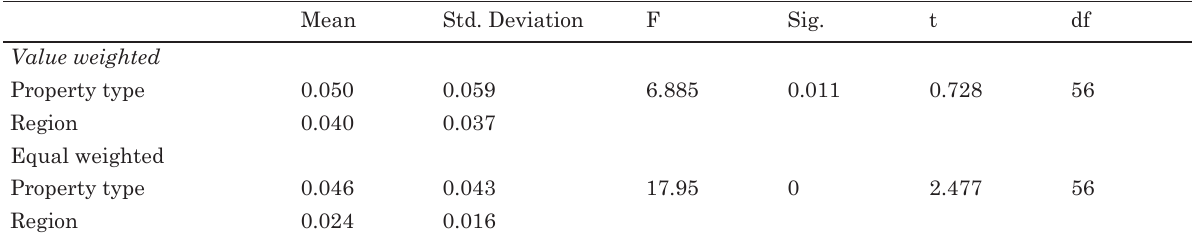
Table 13. Test for equality of means between r square